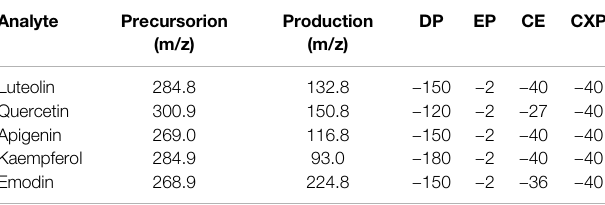
TABLE 4 | MRM transitions for identify of the target